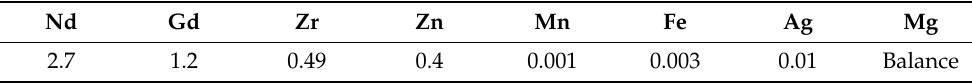
Table 1. Chemical composition of EV31A magnesium alloy (wt.%).